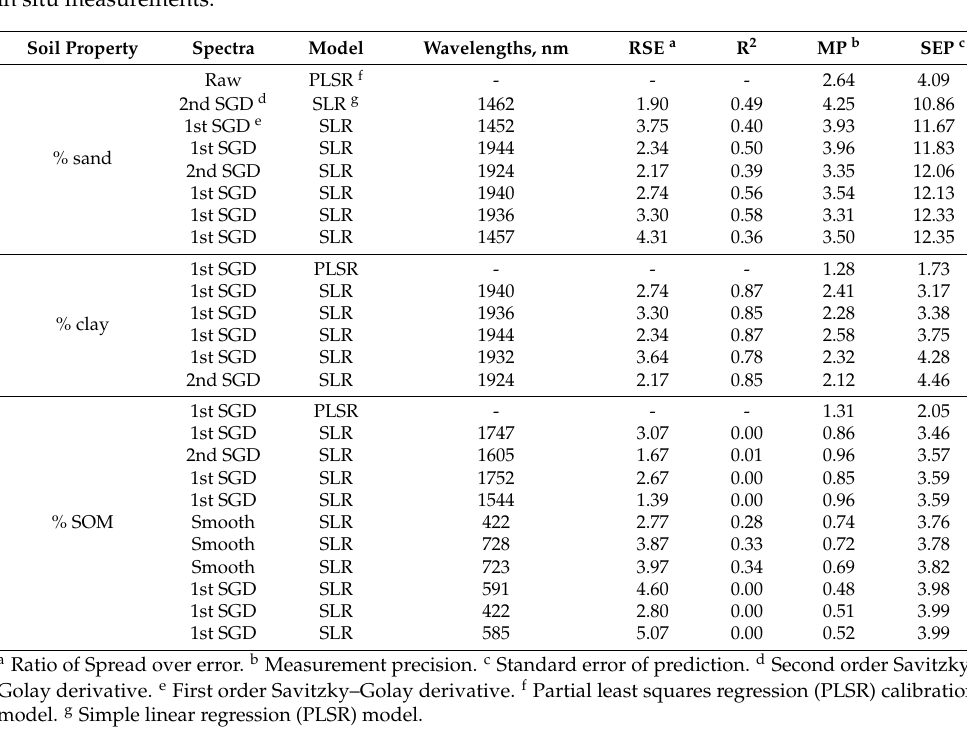
Table 6. Summary of vis–NIR factors demonstrating reproducibility, precision and accuracy during in situ measurements.